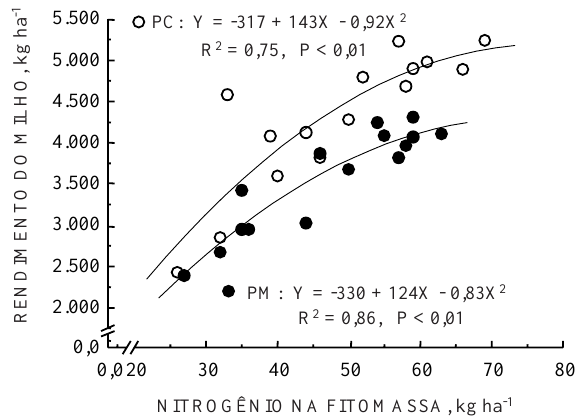
Figura 1. Relação entre a quantidade de nitrogênio na fitomassa da parte aérea e o rendimento de grãos do milho, nos sistemas de preparo convencional (PC) e preparo mínimo (PM). Média de quatro safras no PC e de cinco safras no PM e de três repetições.